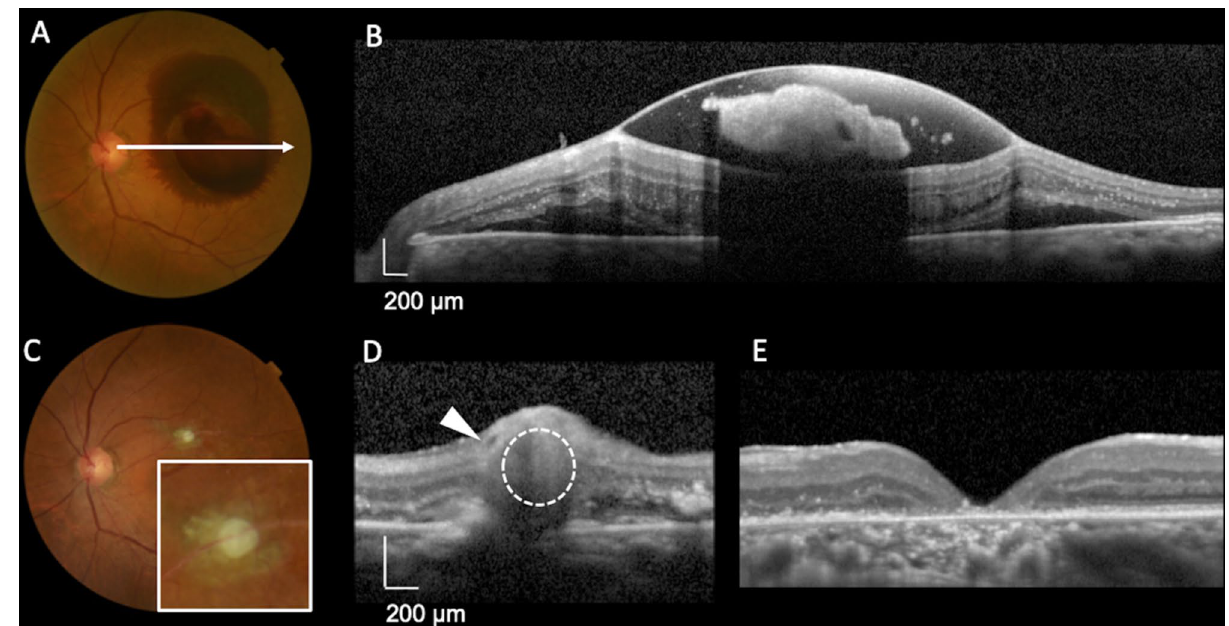
Figure 5. Representative case involving a 74-year-old woman with a ruptured retinal arterial macroaneurysm posterior to the affected artery (posterior type) in the left eye. At the initial visit, the visual acuity was 20/400. Optical coherence tomography (OCT) shows sub-inner limiting membrane (ILM) hemorrhage and a relatively large amount of subretinal hemorrhage ( B ). The thickness of the foveal subretinal hemorrhage was 287 μm. At 5 days after onset, we performed pars plana vitrectomy with ILM peeling, direct photocoagulation of RMA, and sulfur hexafluoride gas tamponade. OCT performed at the time of substantial resolution of the hemorrhage ( D ) shows RMA (dotted circle) located posterior to the artery (arrow), and color fundus photography ( C ) shows the organized white RMA located posterior to the affected retinal artery without obscuring its course. Thus, it was classified as the posterior type. At 24 months after onset, the length of the ellipsoid zone band defect at the fovea was 1725 μm ( E ), and the visual acuity was